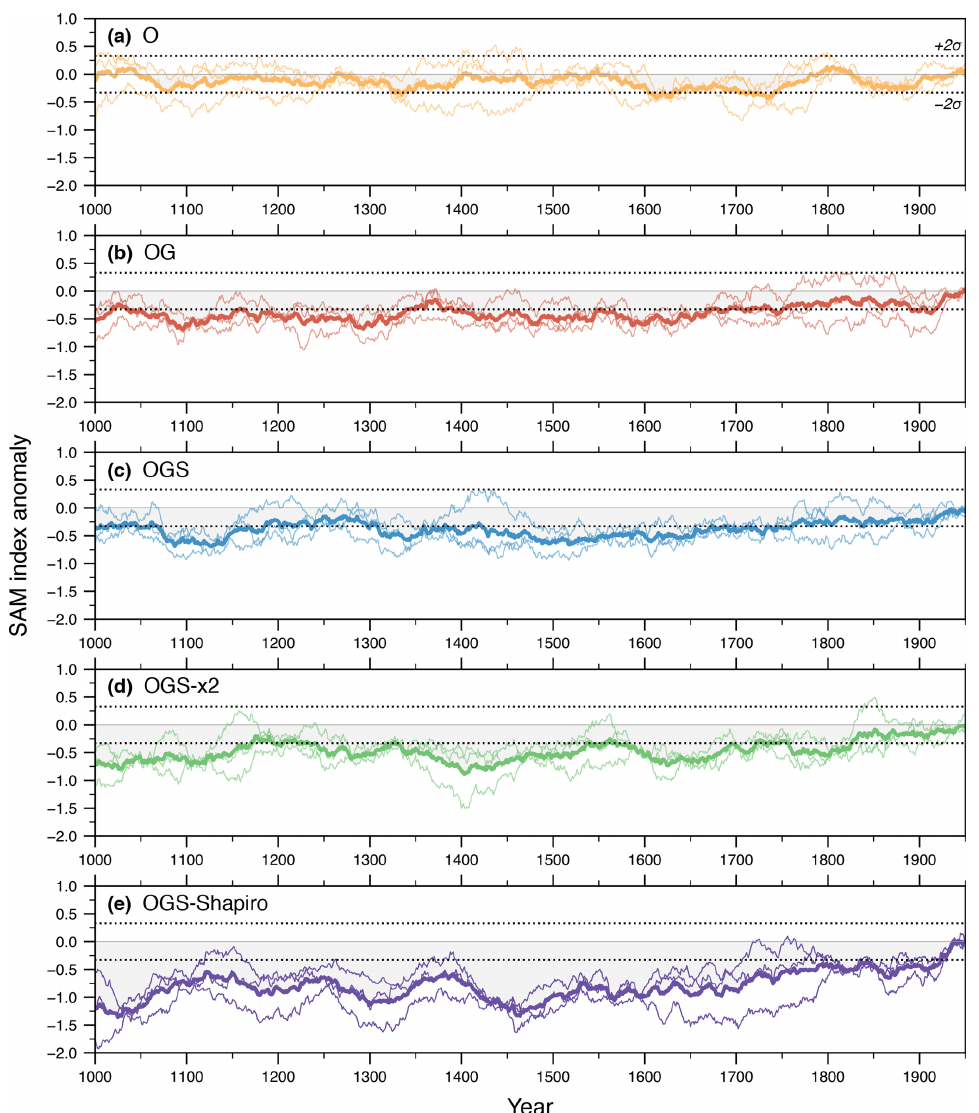
Figure 7. SAM index anomaly based on the different Mk3L simulations. SAM index anomaly is calculated relative to 1900–1999CE mean and shown as 70-year moving averages. (a) Orbital-only (O) simulation; (b) orbital and greenhouse gases (OG) simulation; (c) orbital, greenhouse gases, and low-amplitude solar-forcing (OGS) simulation; (d) orbital, greenhouse gases, and the intermediate-amplitude solar- forcing (OGS-x2) simulation; (e) orbital, greenhouse gases, and high-amplitude solar (OGS-Shapiro) simulation. Thick lines refer to the ensemble mean, while thin lines denote the individual ensemble members. Dashed lines on all subplots show the ± 2 σ range based on the orbital-only (O) simulations, representing internal